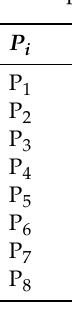
Table 5. Residual permanent